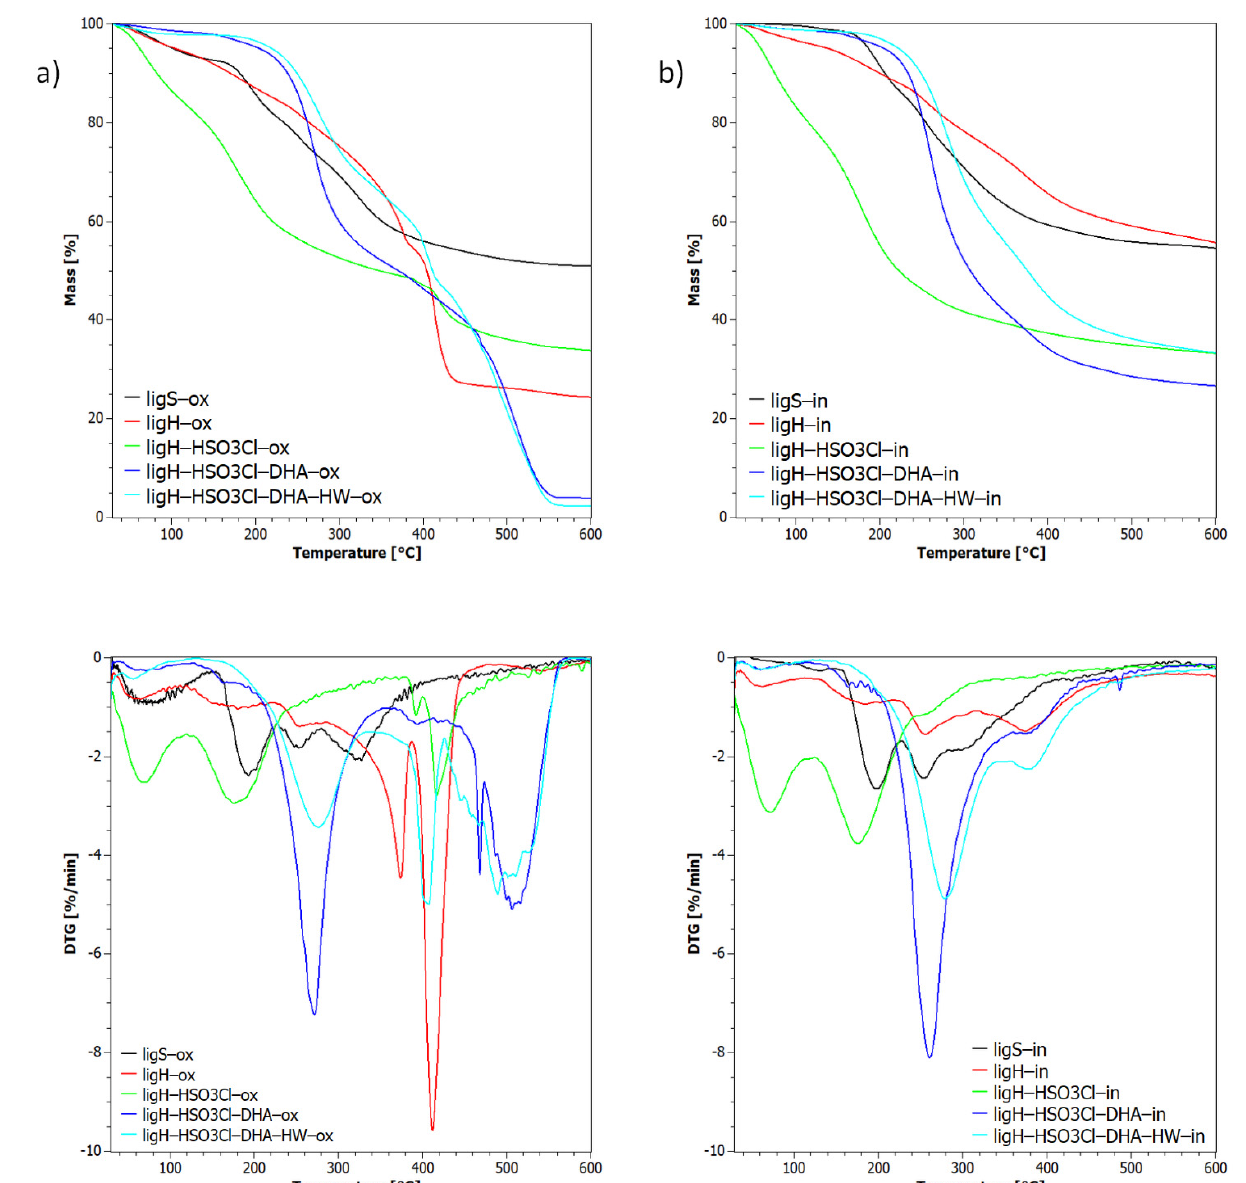
Figure 7. TG and DTG curves of the investigated materials during thermo-oxidative ( a ) and pyrolitic ( b ) degradation.